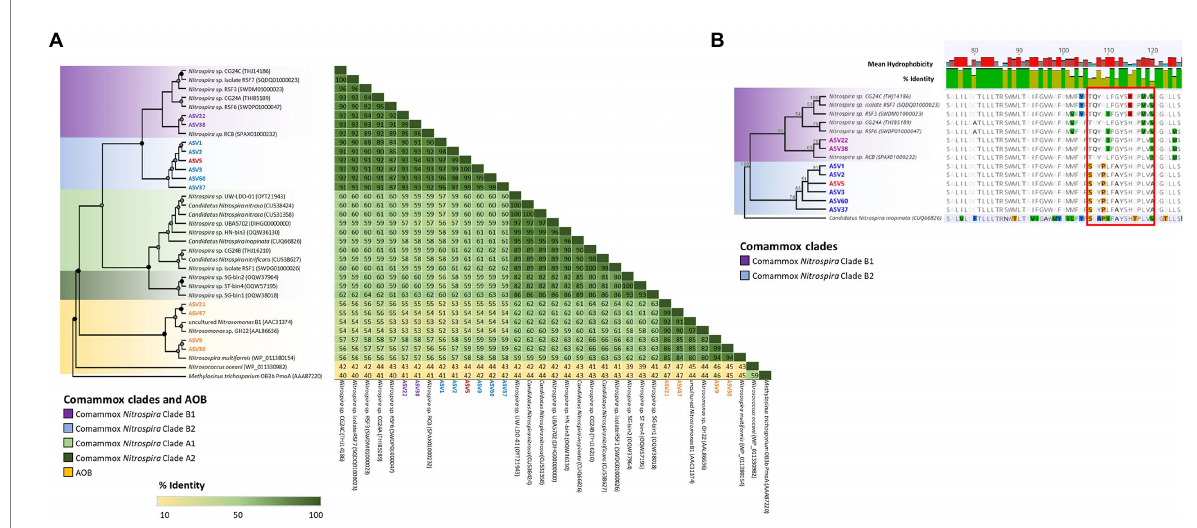
FIGURE 5 Phylogenetic analysis of comammox Nitrospira and ammonia oxidizing microorganisms AmoA sequences. The maximum likelihood tree was constructed using protein alignment of 133 aa sequences (A) . Comammox Nitrospira clades and ammonia oxidizing bacteria (AOB) are indicated with colored boxes. Bootstrap support values of 100% are indicated with black circles, and ≥ 60% are indicate with a grey circle. The tree branches were transformed and drawn proportionally (A) . Highlighted ASV indicated the most abundant ASVs from each commamox clades and AOB subclasses. Methylosinus trichosporium OB3b PmoA (AAA87220) was used as the outer group. Detailed protein alignment is shown from residue 74–126 (B) where red boxed area indicates high amino acid variables between comammox Nitrospira Clade B1 and B2 (residue 106–120). Candidatus Nitrospira inopinata (CUQ66826) was used as an outer group with 100% bootstrap